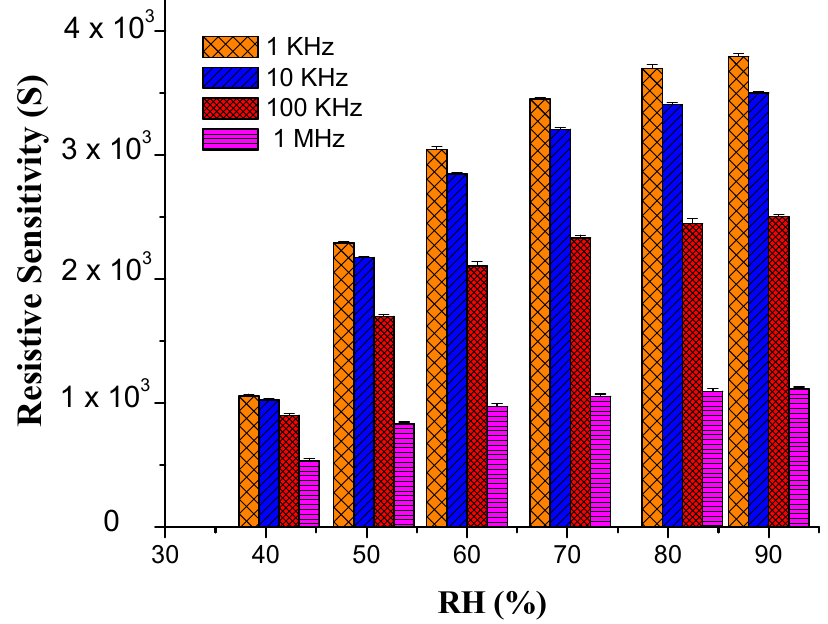
Figure 4. Resistivity Sensitivity of PEO-CuO-MWCNT:1% nanocomposite at different % RH.